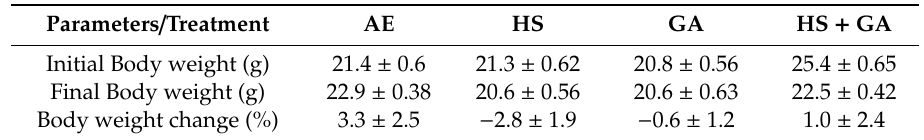
Table 1. Some physiological parameters of mice exposed to air (AE) or hookah smoke (HS) with or without gum acacia (GA) treatment.